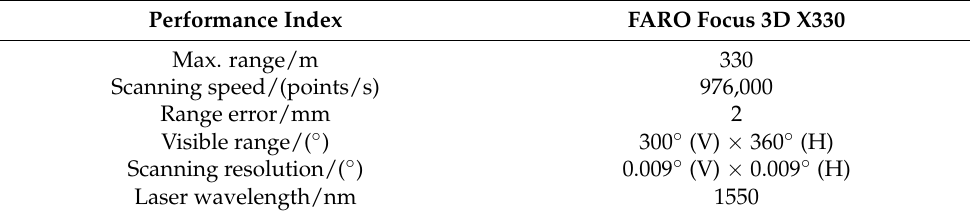
Table 3. FARO Focus 3D X330 parameters.